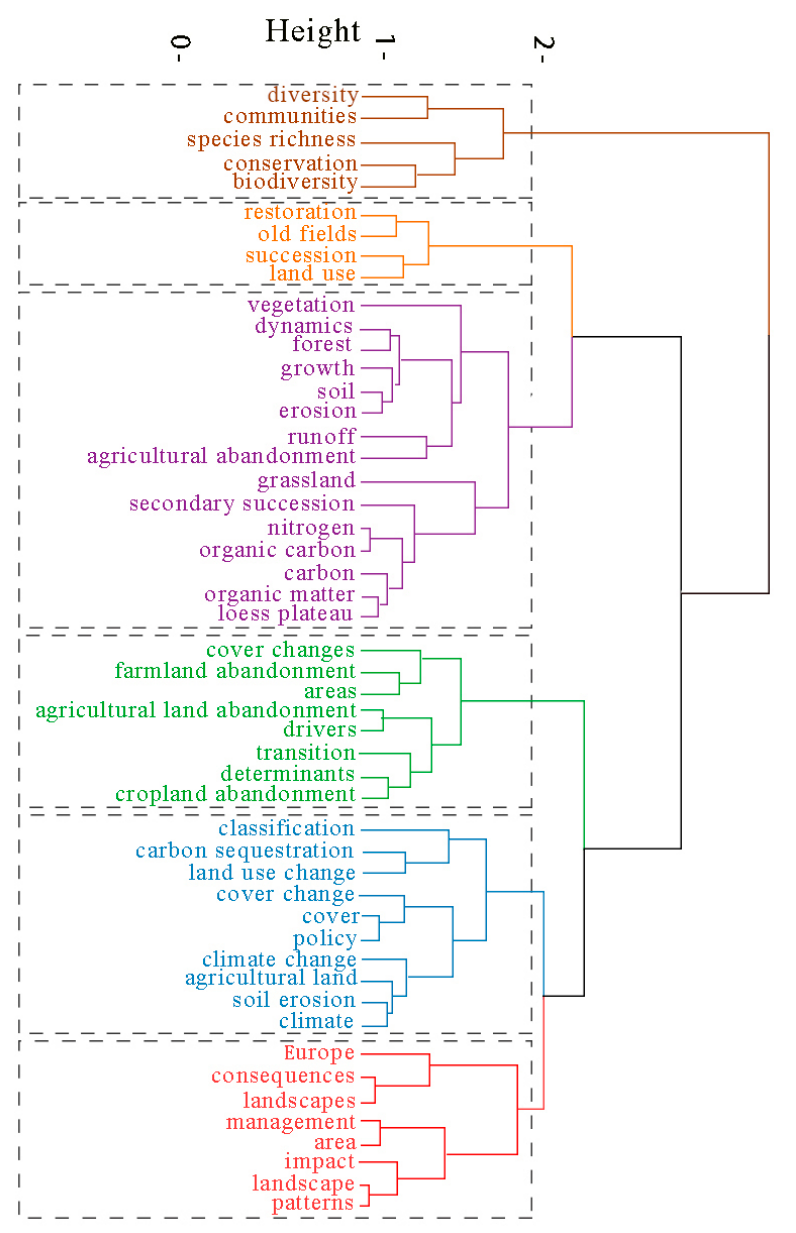
Figure 8. Hierarchical clustering analysis of keywords in the field of farmland abandonment.